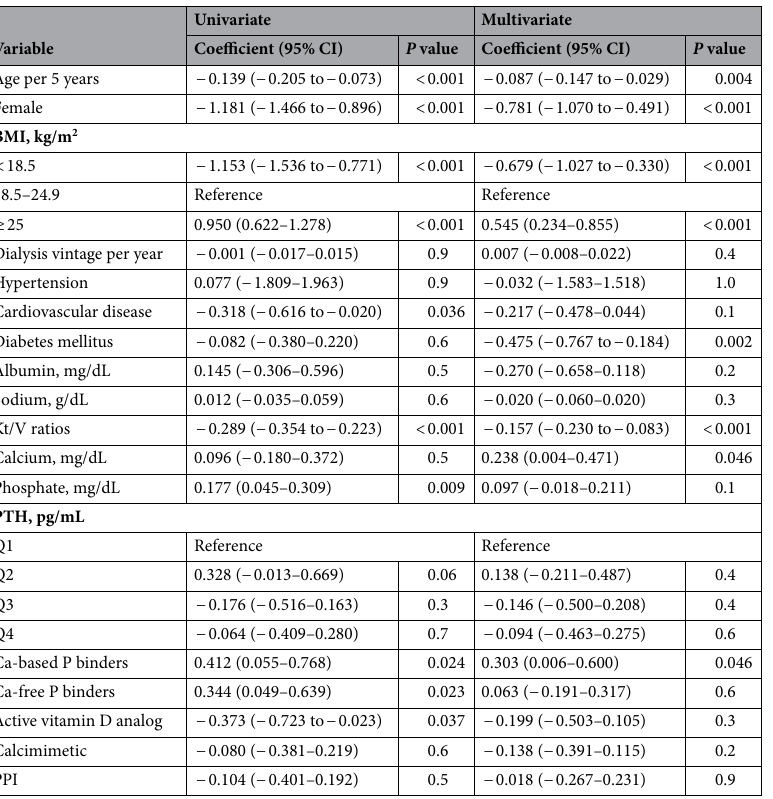
Table 3. Univariate and multivariate linear regression analyses examining the association between covariates and bone mineral density. Bone mineral density is based on a T-score that is the number of standard deviations compared with healthy young controls. β coefficients with the corresponding 95% confidence intervals (95% CIs). P < 0.05 was considered significant. BMI, body mass index; Ca, calcium; P, phosphate; PPI, proton pump inhibitor; PTH, parathyroid hormone; Q,